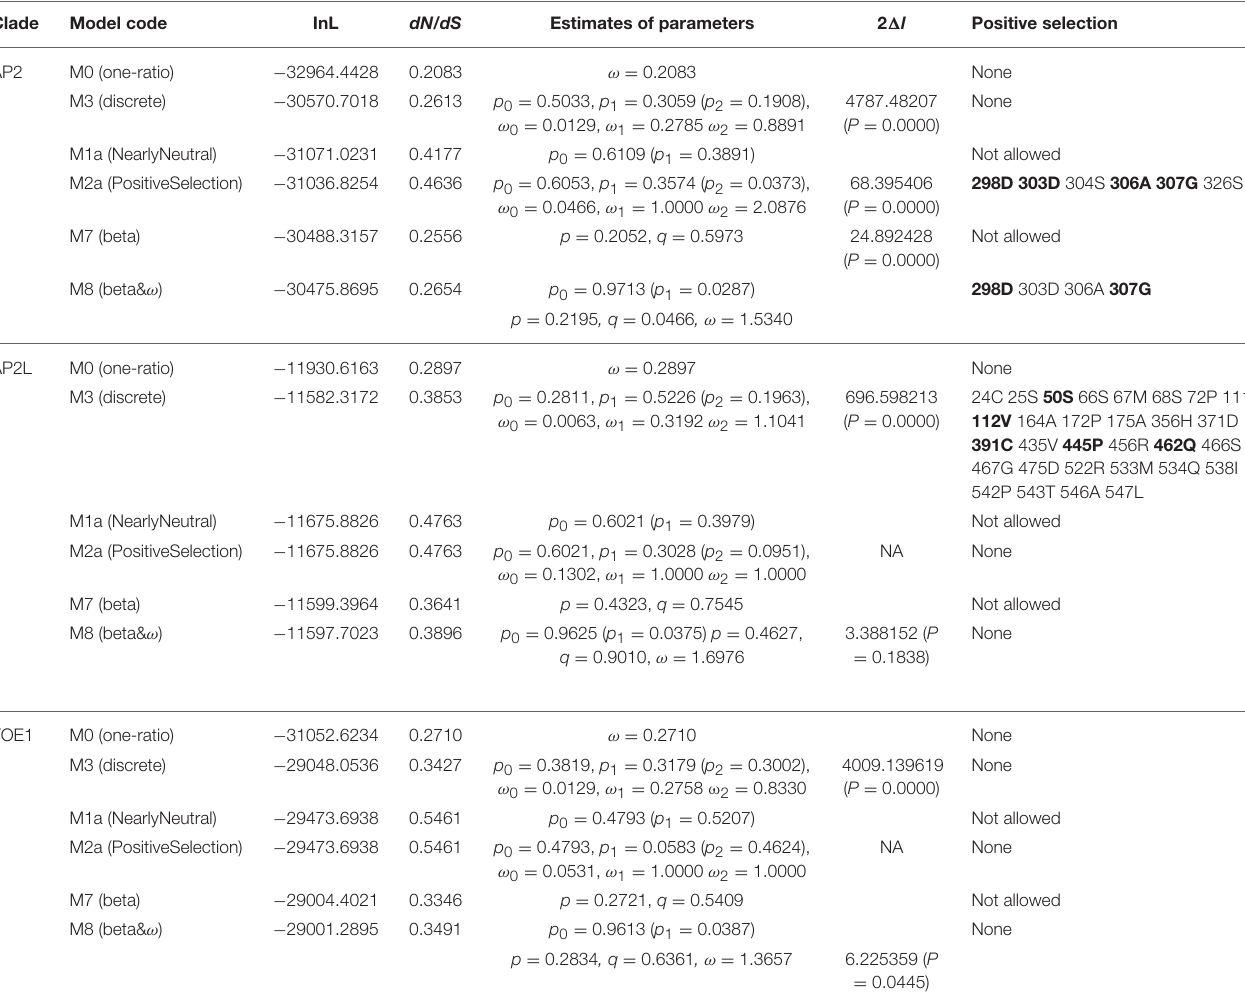
TABLE 2 | Likelihood Values and Parameter Estimates for AP2, AP2L, and TOE1 Clades Genes Sequences. Clade Model